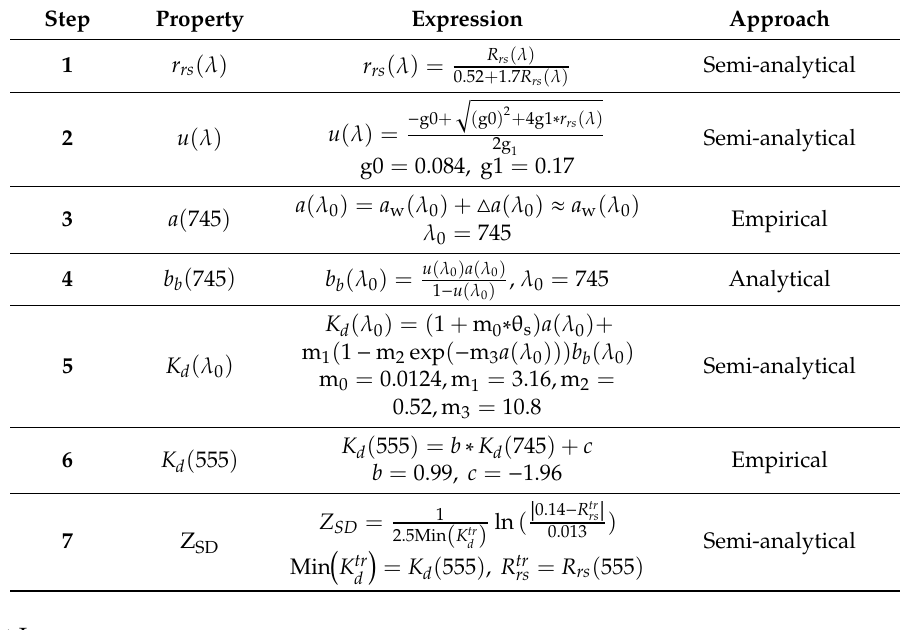
Table 1. Steps of Z SDZ algorithm (a new semi-analytical